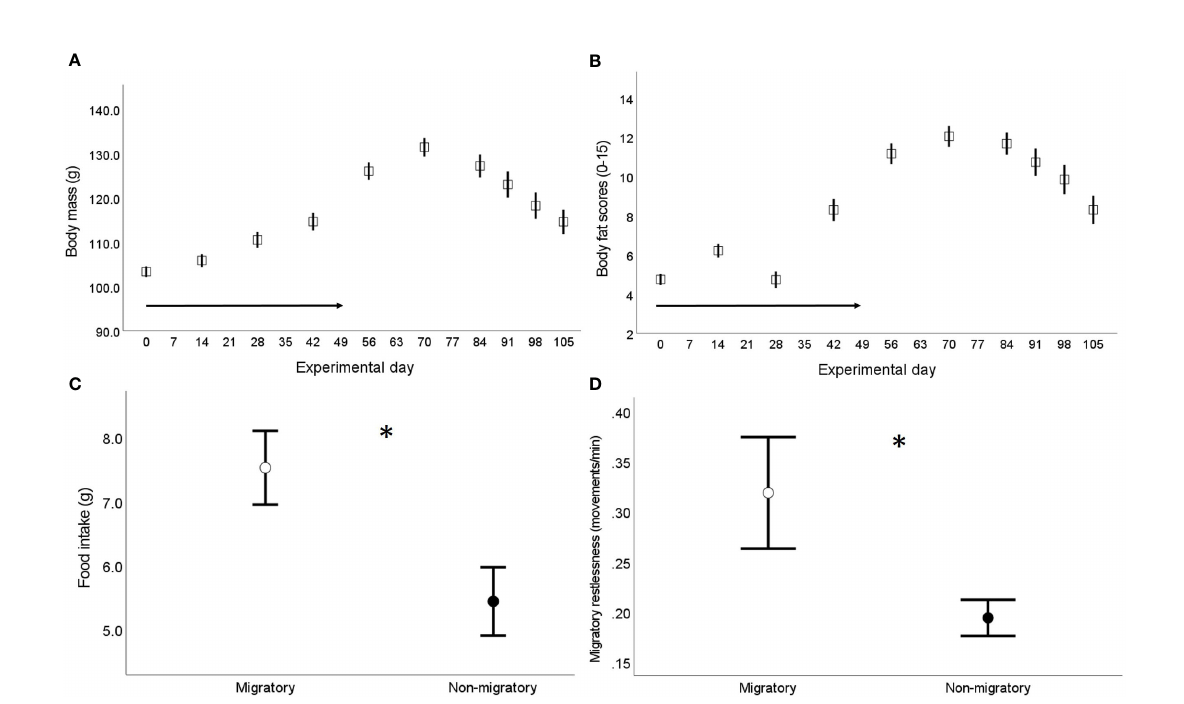
FIGURE 1 Assessment of physiological migratory state in the captive population of common quails used in the main experiment (56) – birds aged seven weeks old when the experiment started (experimental day 0). (A) Changes in body mass and (B) total subcutaneous fat scores (assessed in the furcular, scapular and abdomen following Boswell et al. (55) over the experimental period; the arrow in both fi gures indicates the weekly reduction in daylight (experimental days 0-49); sample size from experimental days 0-56: 68 birds, sample size from experimental days 70-105: 35 birds. (C) Food intake (g) and (D) migratory restlessness (i.e. average nocturnal activity levels) separately by sampling group (n=33 migratory and 35 non-migratory) assessed when the birds were singly housed, 1-3 days prior blood sampling in the migratory group (experimental days 56-70) and the non-migratory group (experimental days 105-119). Data are presented as means ± se; * indicates p <